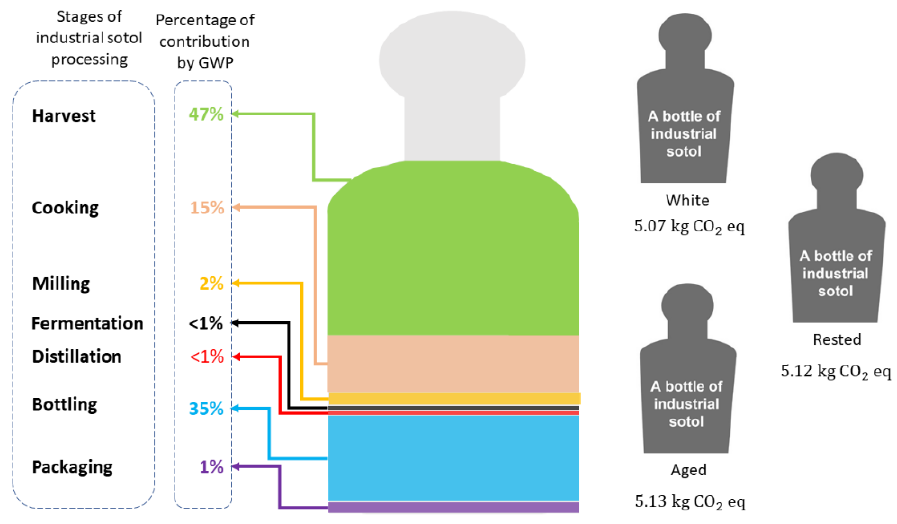
Figure 2. GHG emissions per sotol variety.